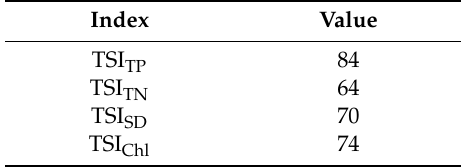
Table 5. The trophic status index (TSI) calculated for Miłkowskie Lake on the basis of the visibility (SD), chlorophyll concentration (Chl), total phosphorus (TP) and total nitrogen (TN) in 2018.